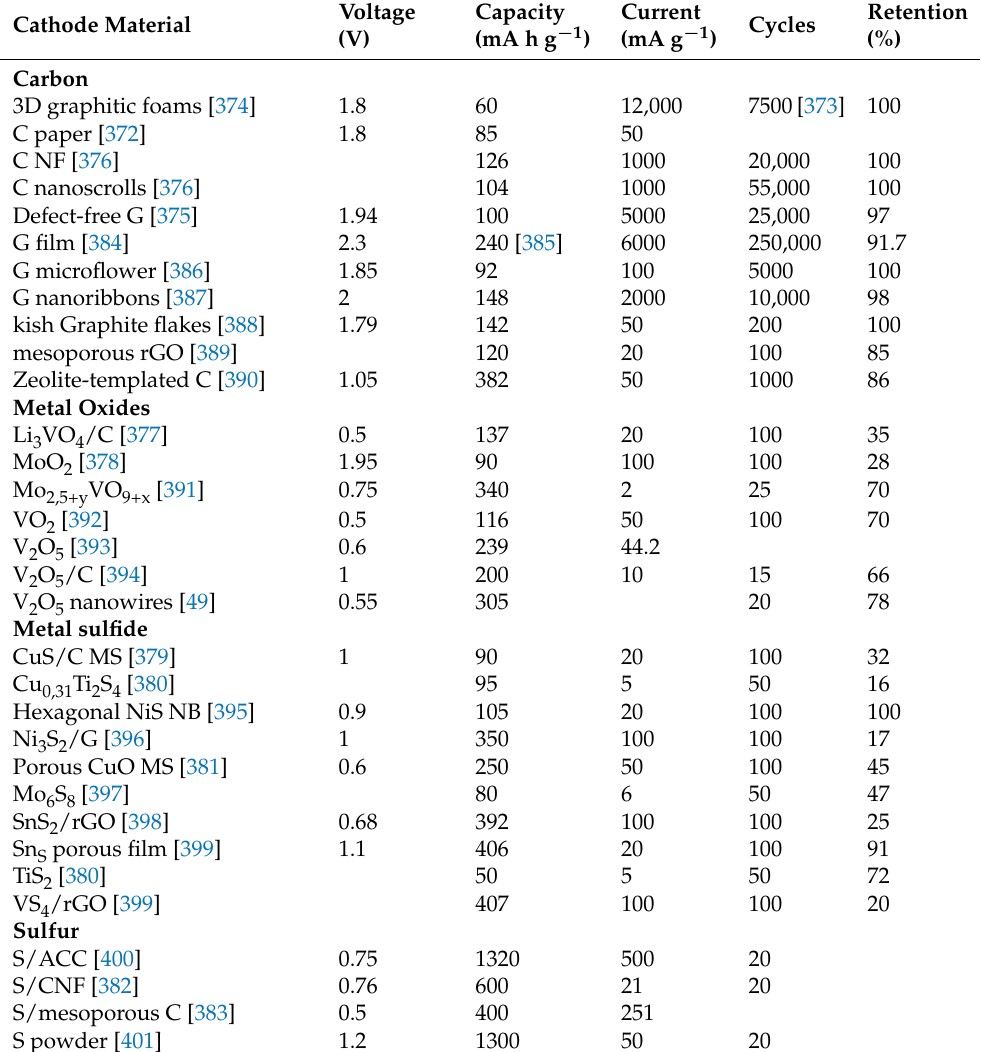
Table 14. Cathode materials for Al-based